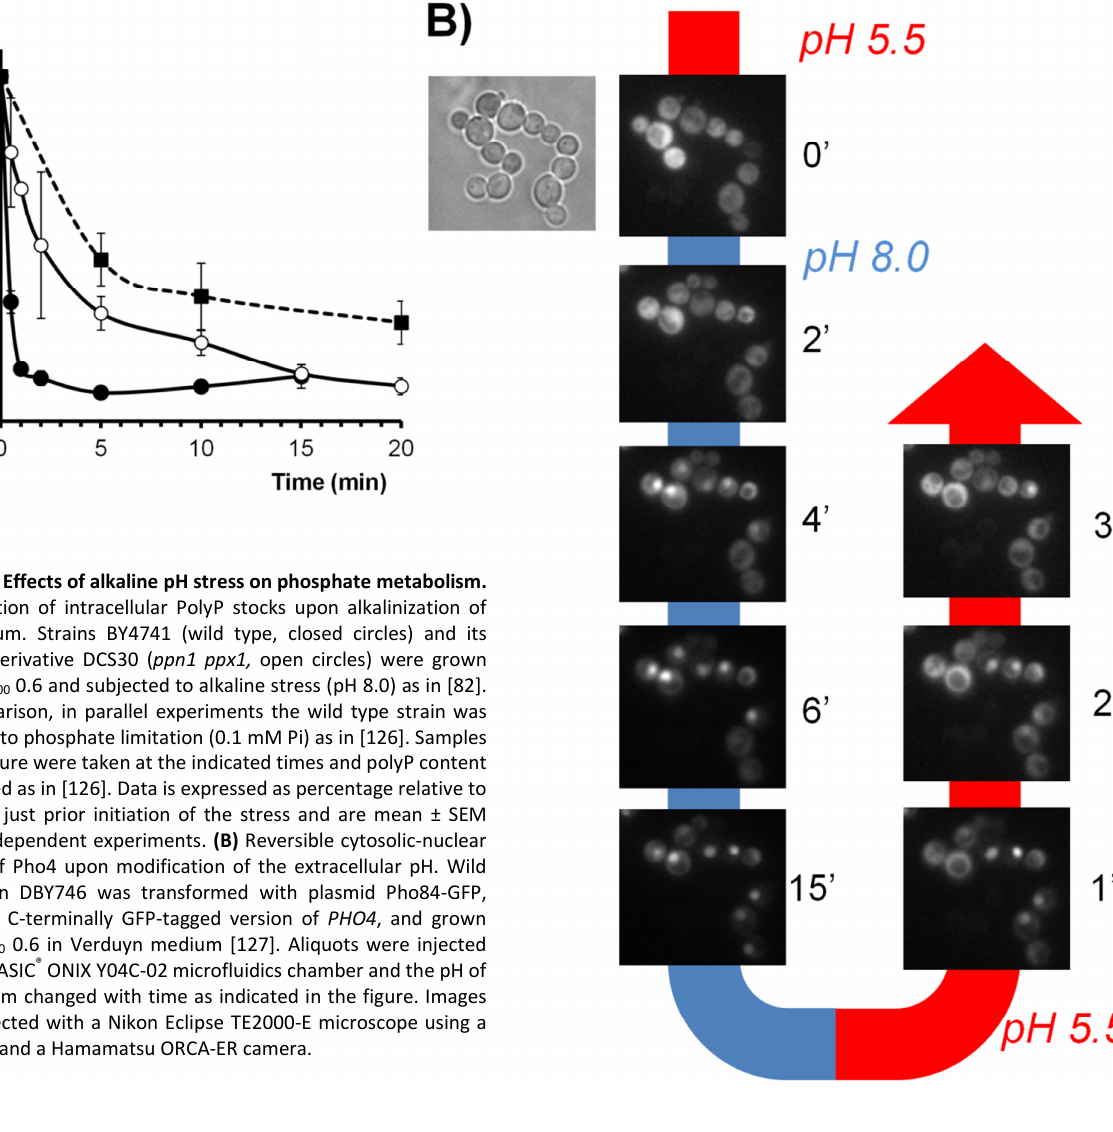
OPEN ACCESS | www.microbialcell.com 189 Microbial Cell | June 2015 | Vol. 2 No. 6